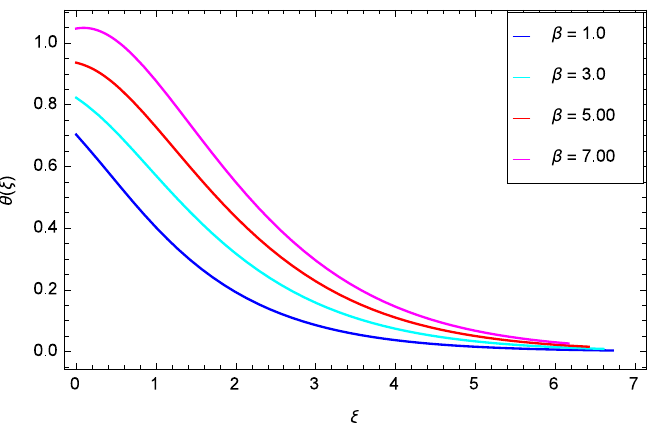
Figure 9. Impact of the ferrohydrodynamic interaction parameter β on temperature θ ( ζ ) .